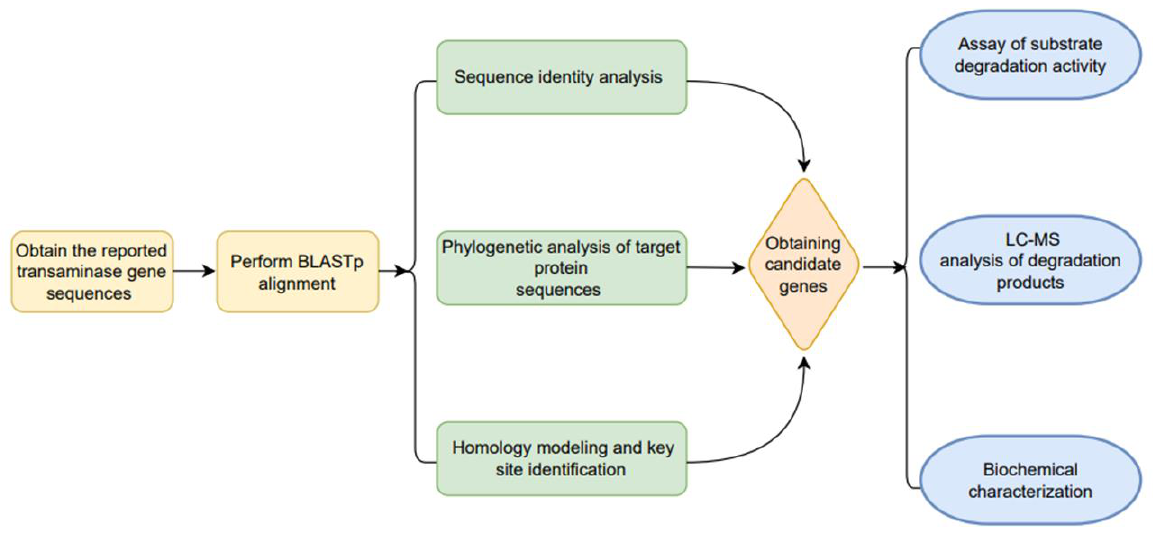
Figure 1. Screening and identification of FB1 detoxification transaminases.